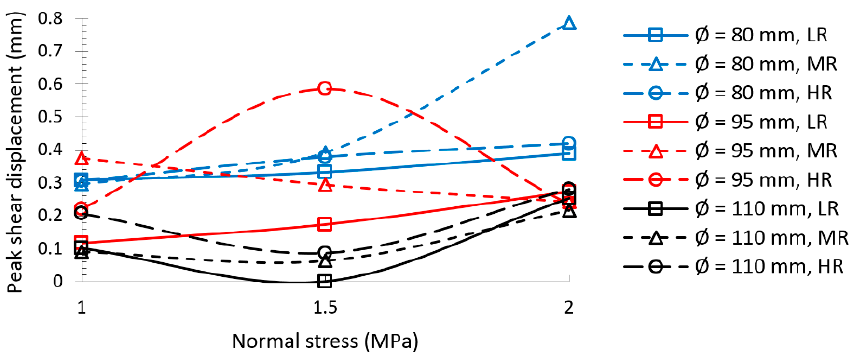
Figure 8. Peak shear displacement of J&Br specimens embedding a single joint with different sizes and roughness under different normal stress levels.